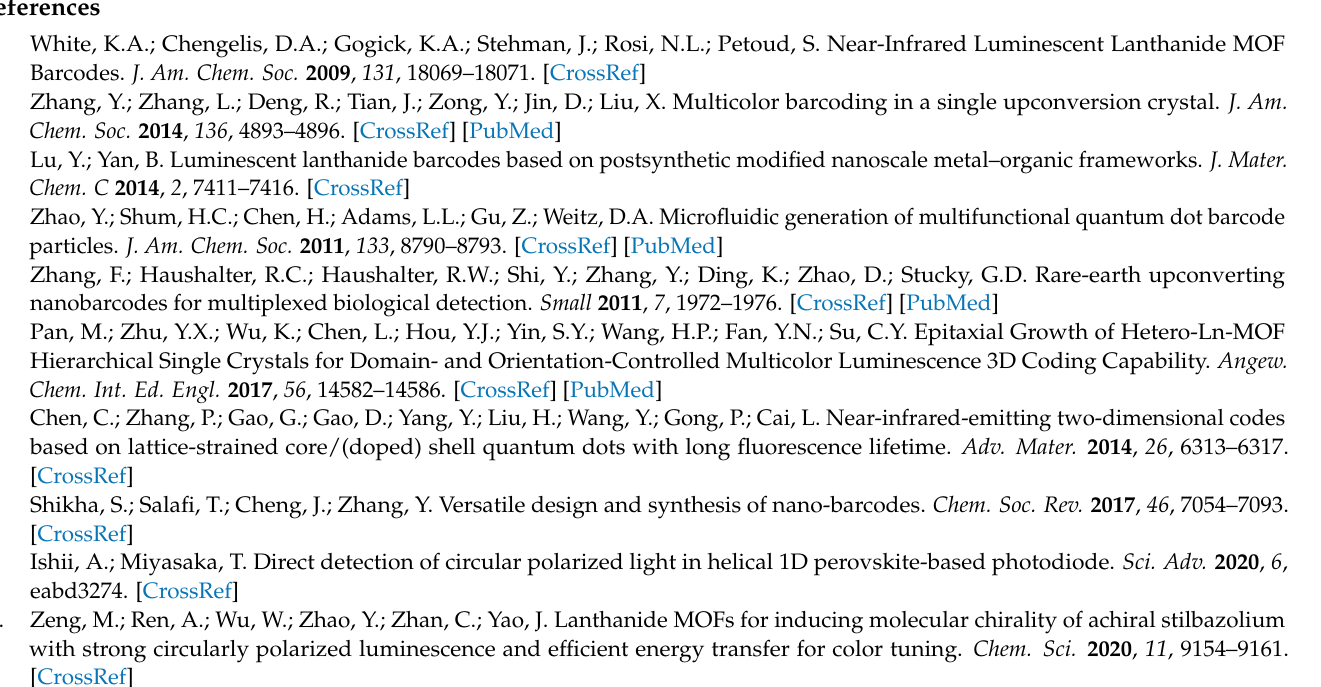
600 Oe dc field. Figure S4: Plots of χ ” versus T for complex 1 at 997 Hz under 0, 1500 and 2000 Oe dc field, respectively. Figure S5: Plots of temperature dependent χ (cid:48) ac susceptibility for complex 1 ( H dc = 1500 Oe). Figure S6: Cole-Cole curves at 1.9 − 2.3 K ( H dc = 1500 Oe, H ac = 2.5 Oe). Table S1: The coordination geometry of Dy1 in 1a calculated by SHAPE software. Table S2: Cole-Cole curve fitting parameters for complex 1